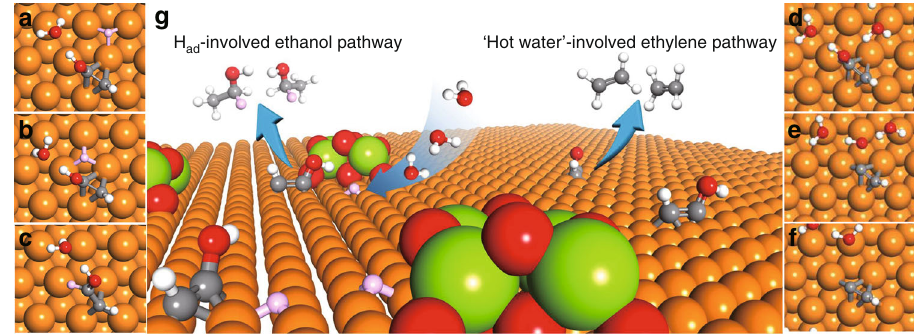
Fig. 4 Density functional theory calculations on the ethylene and ethanol pathways. Top views of geometries a initial state, b transition state, and c fi nal state of key reaction towards ethanol, and d initial state, e transition state, and f fi nal state of key reaction towards ethylene. Red, white, gray and orange balls stand for oxygen, hydrogen, carbon, and copper, respectively, while pink balls stand for H ad